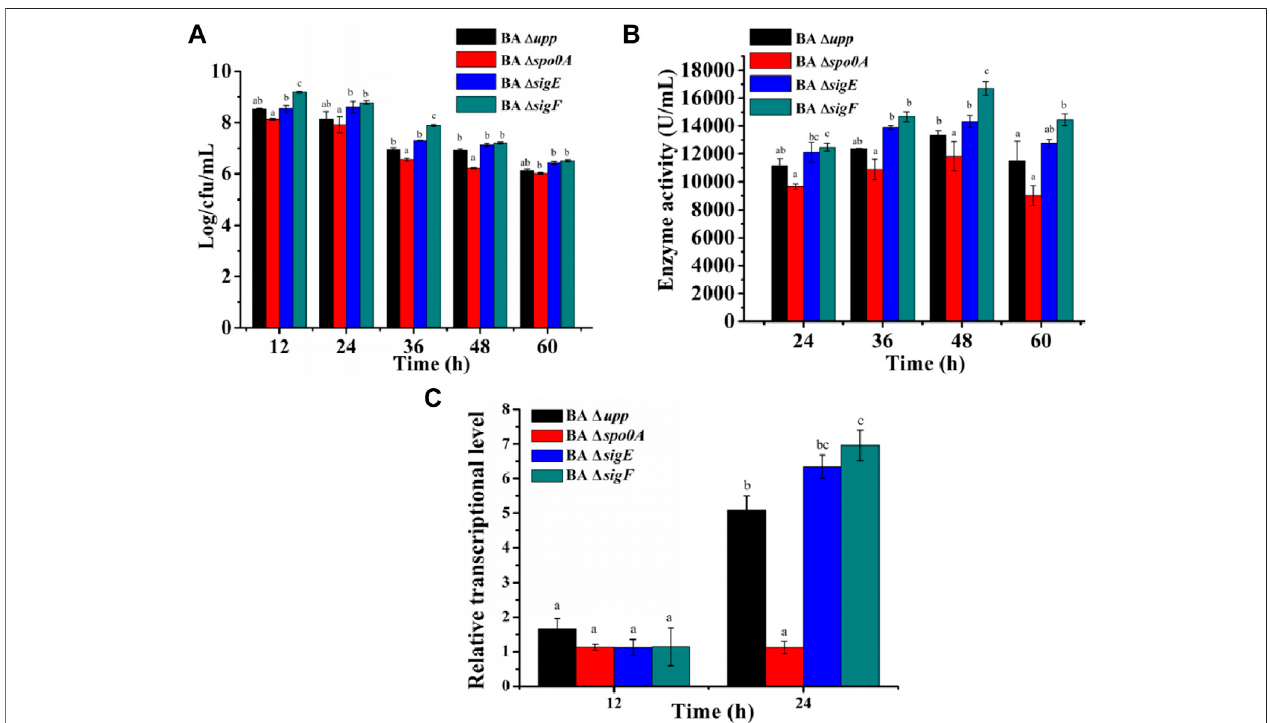
FIGURE4| Analysisofbiomassandalkalineproteaseenzymeactivityassaysofthesporulation-de fi cientstrainsandtheparentalstraininfermentationmedium. (A) Theviablecountsofthedifferentstrainswasmeasuredbyculturinginfermentationmedium,at12,24,36,48,and60 h,respectively.Dataarepresentedasmeanvalues SD. n = 3 biologically independent samples. (B) Alkaline protease enzyme activity of the different strains was measured by culturing in fermentation medium, at 24, 36, 48, and 60 h, respectively. Data are presented as mean values SD. n = 3 biologically independent samples. (C) The relative gene expression levels of aprE of the different strains was measured by culturing in fermentation medium at the log phase (12 h) and the stable phase (24 h). Data are presented as mean values SD. n = 3 biologically independent samples. Means with the different letters are signi fi cantly different according to Duncan ’ s multiple range test at p < 0.05.